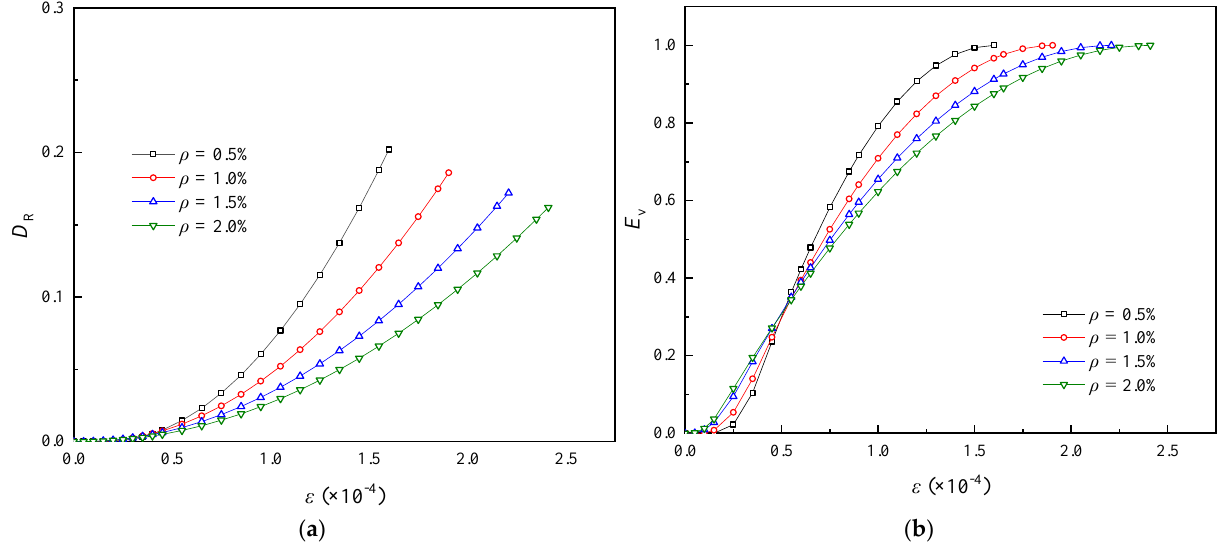
Figure 13. Evolution curves of damage variable and evolution factor: ( a ) D R - ε curves; ( b ) E v - ε curves.